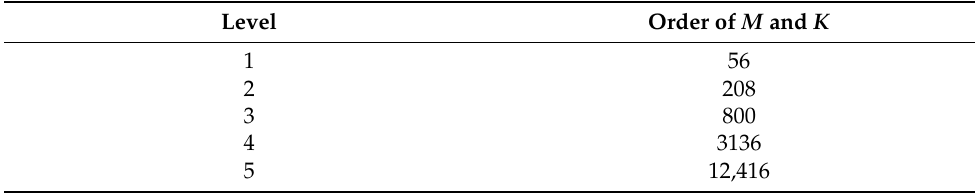
Table 6. The relationship between matrix order and mesh refinement level (2D). Level Order of M and K